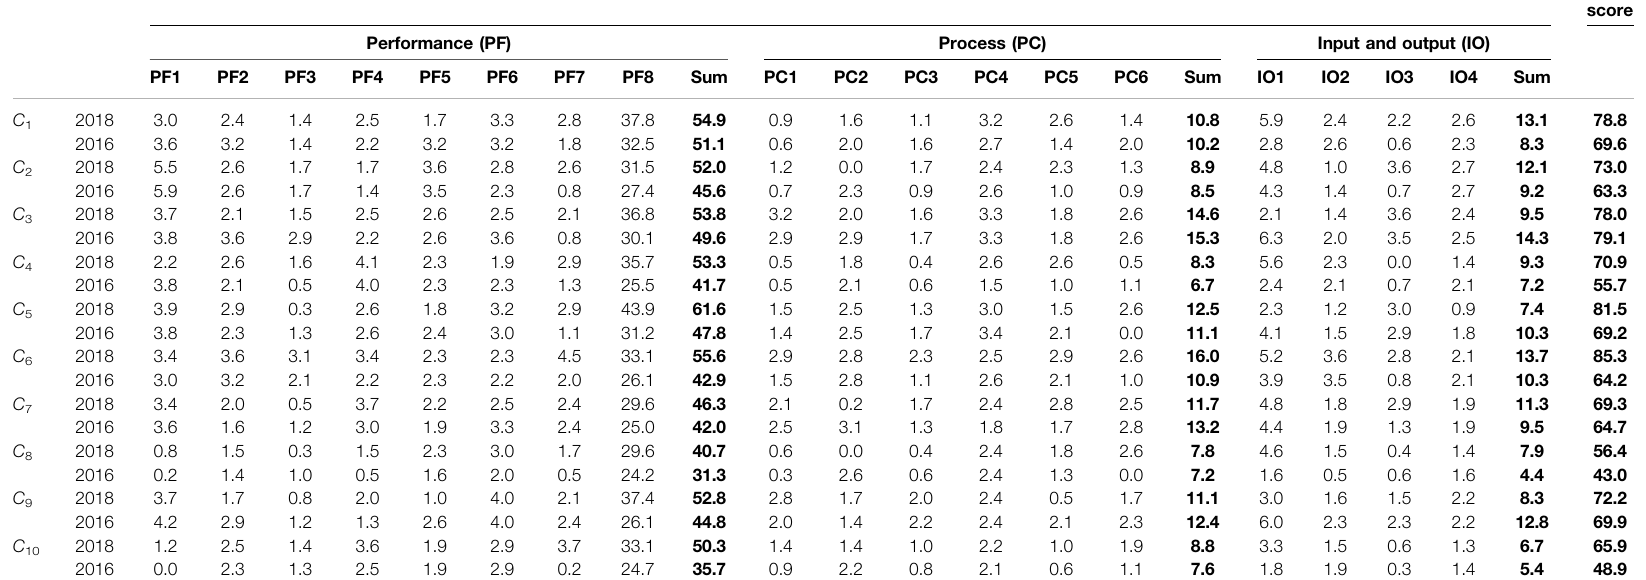
TABLE 6 | Indicators weights of ten cities.